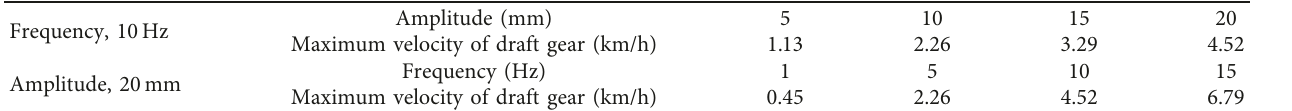
Figure 7: Shunting impact simulation with the wedge-spring model and comparisons of simulation results. (a) 4 km/h shunting impact simulation and test results. (b) 6 km/h shunting impact simulation and test results. (c) 7km/h shunting impact simulation and test results. (d) Comparison of the simulation results at different initial Table 1: Experimental parameters.